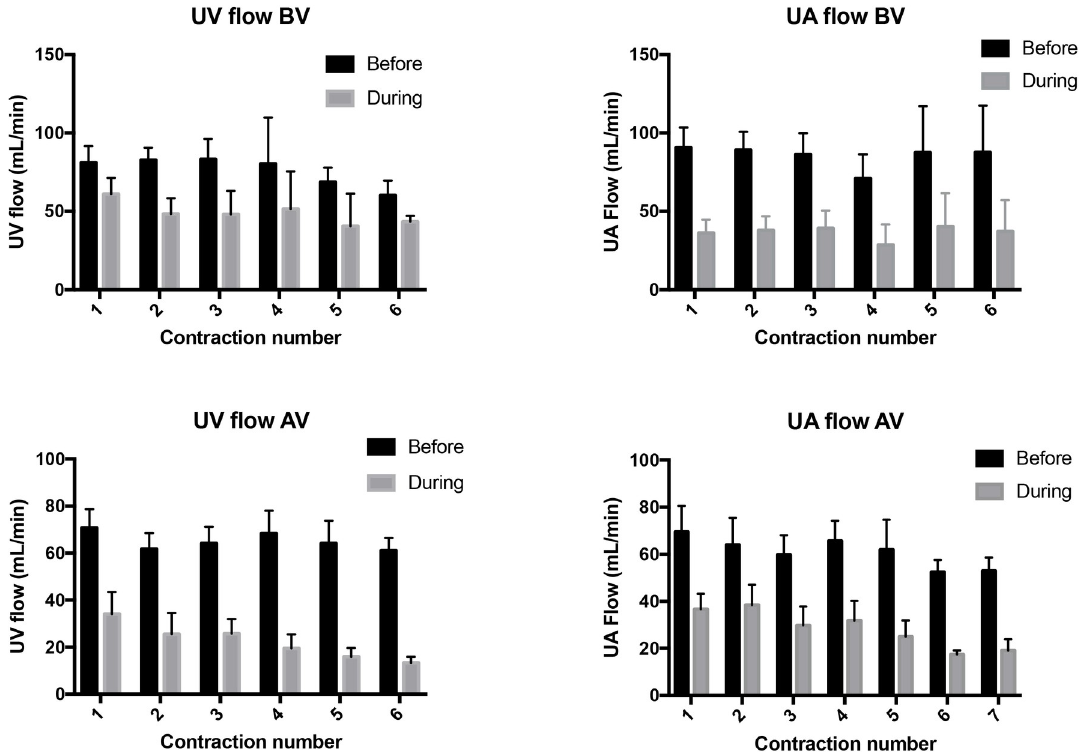
Fig 3. Blood flow in the umbilical vein (UV) and umbilical artery (UA) measured immediately before (black bar) and during (grey bar) consecutive uterine contractions and before (BV) and after (AV) ventilation onset. UV and UA blood flows measured during each contraction were significantly lower than flows measured immediately prior to the contraction (p < 0.0001).